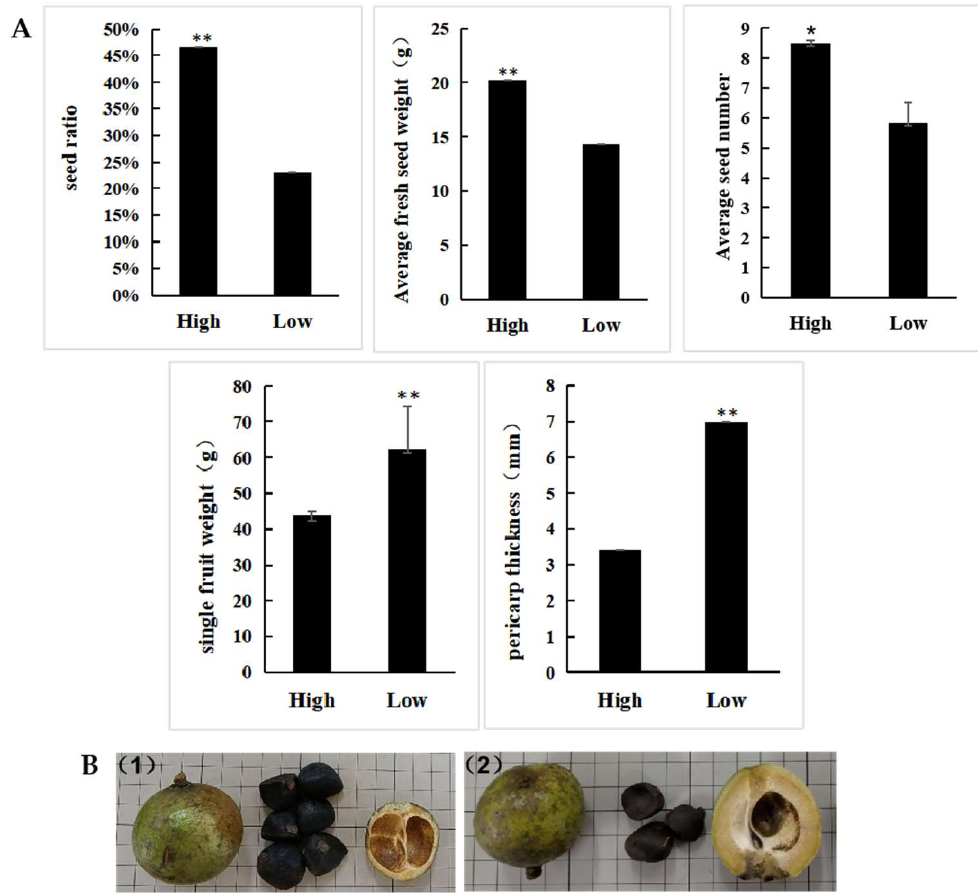
Figure 2. Phenotypic data ( A ) and architecture ( B ) of high- and low-seed-ratio C. vietnamensis fruits. ( 1 ) Architecture of high-seed-ratio fruit ; ( 2 ) Architecture of low-seed-ratio fruit. Asterisks indicate significant differences: * p < 0.05 and ** p < 0.01.